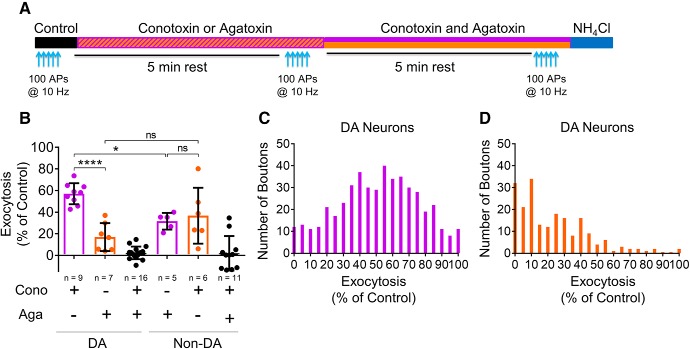
CaV2.1 and CaV2.2 contribute to SV exocytosis in VTA neurons. A, Schematic of protocol using trains of 100 APs in the absence (black) or presence of ω-conotoxin GVIA (cono, 1 μM, purple bar) alone, ω-agatoxin IVA (aga, 400 nM, orange bar) alone, or both toxins together. B, Comparison of the effect of conotoxin and agatoxin on dopaminergic and non-dopaminergic neurons. The combination of conotoxin and agatoxin abolished exocytosis in both dopaminergic (DA) and non-dopaminergic (non-DA) neurons; ****p < 0.0001; *p < 0.05; ns, not significant by unpaired one-way ANOVA, Tukey’s post hoc test. C, Histogram displaying the bouton-by-bouton effect of conotoxin alone on exocytosis in dopaminergic neurons for all boutons (n = 9 neurons). Data have been constrained from 0% to 100% of control exocytosis. D, Histogram displaying the bouton-by-bouton effect of agatoxin alone on exocytosis in dopaminergic neurons for all of boutons (n = 7 neurons). Data have been constrained from 0% to 100% of control exocytosis.